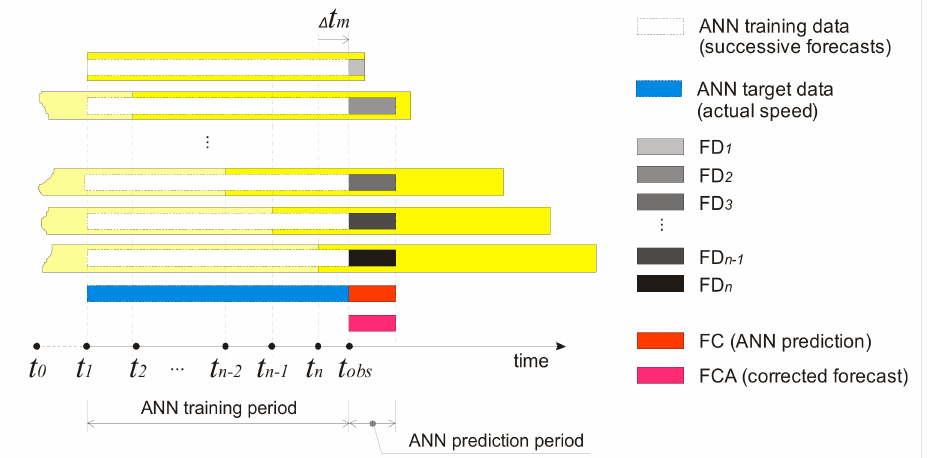
Figure 6. ANN data sets during long critical wind